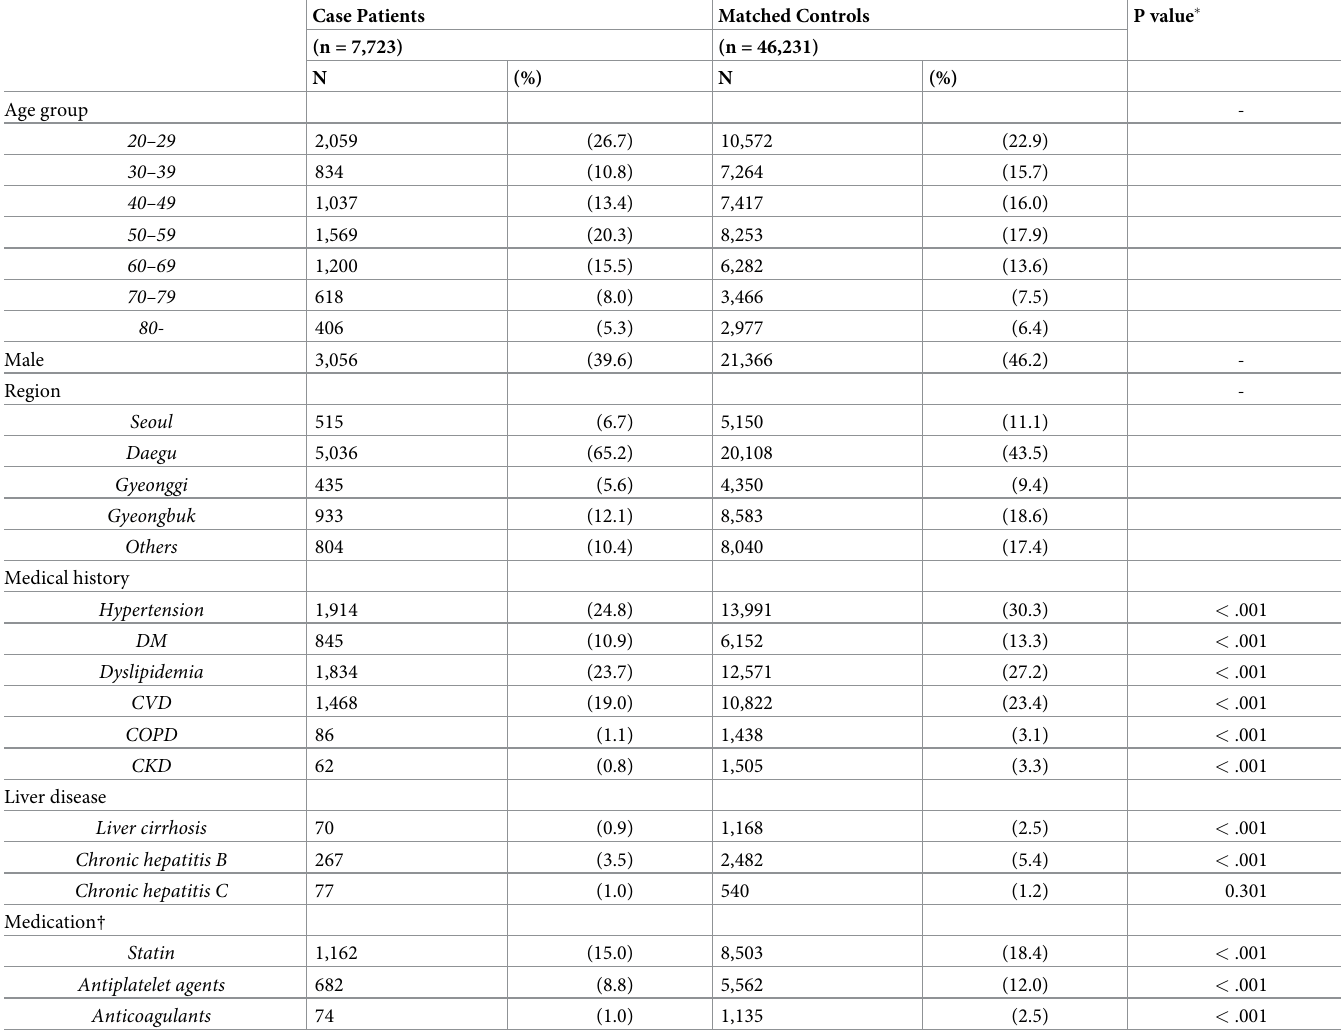
Table 1. Demographic and clinical characteristics of patients with COVID-19 (case patients) and subjects with negative test result (matched